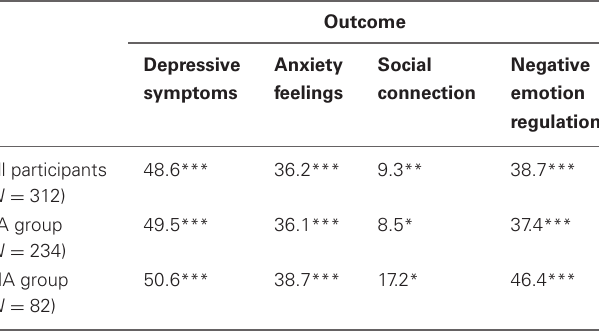
Table 4 | Percentage of variance explained by Model 3, by